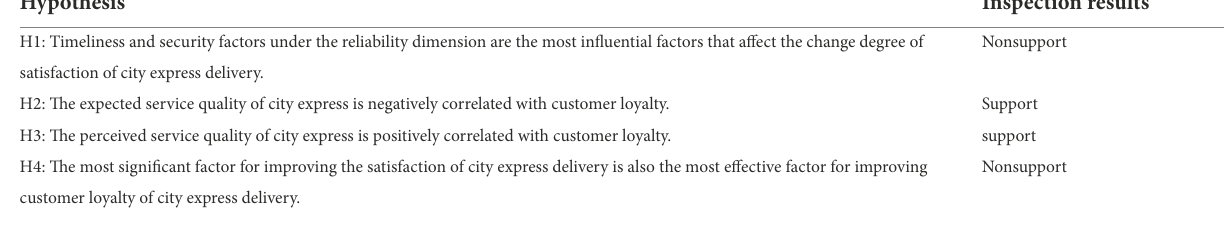
TABLE 11 Experimental results of the hypothesis.